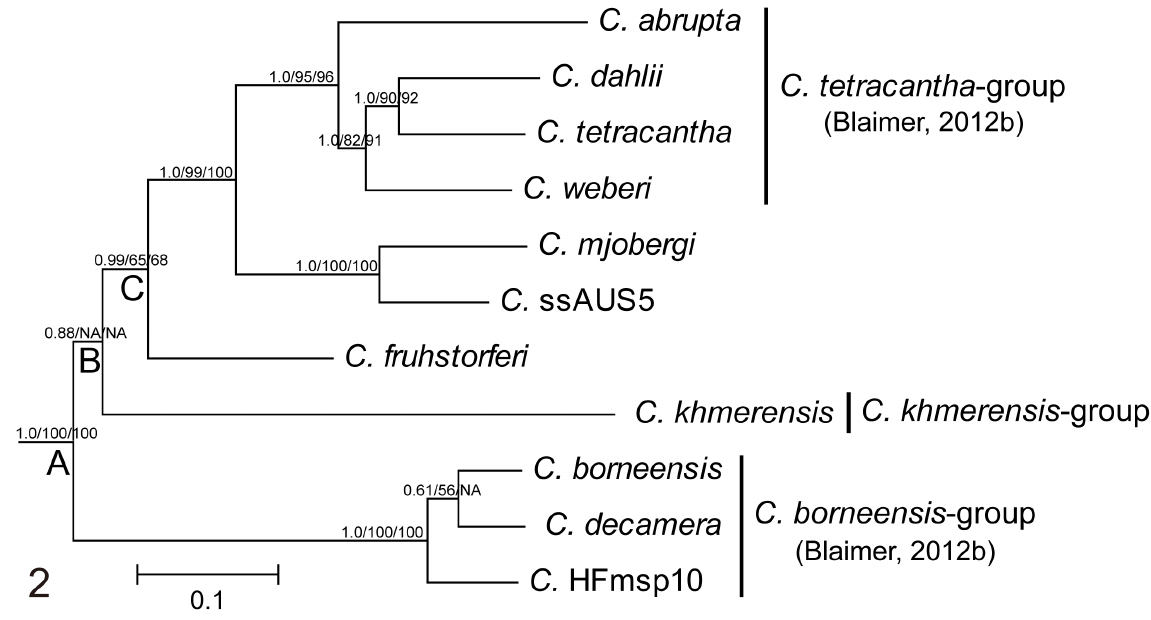
Fig. 2. Bayesian majority rule consensus tree reconstructed for 90 taxa using five genes (ArgK, CAD, LWRh, Top1, Wg) in a MrBayes analysis. Most of the outgroups are not shown. Above node numbers indicate posterior probability, bootstrap value for MP, and bootstrap value for ML. Data were partitioned by PartitionFinder v.1.1.1 and analyzed using a best fit model for each gene and codon position, with 10 million generations and a burn-in of 25 %.